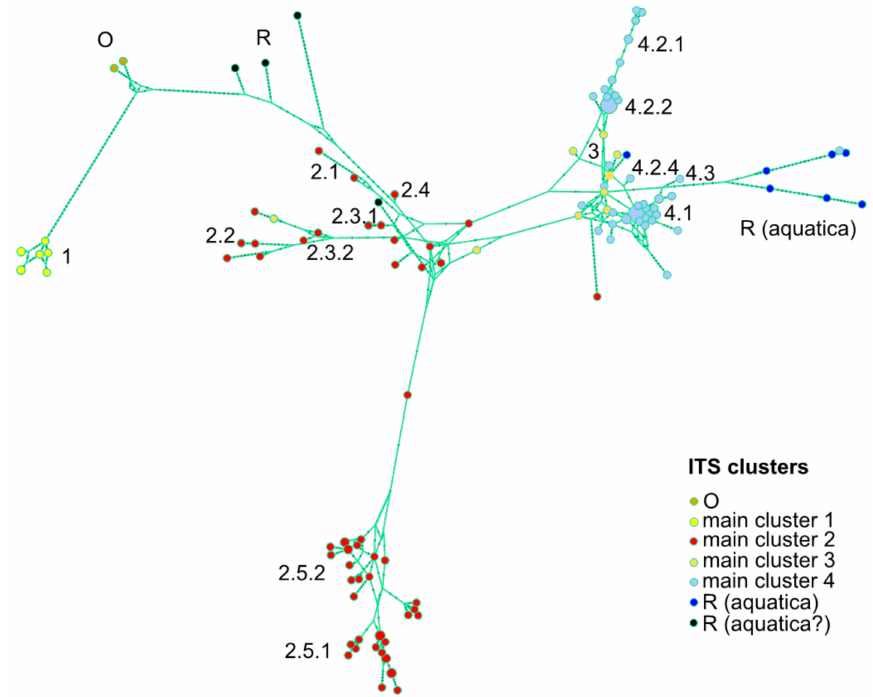
Figure 2. Haplotype network. Subcluster codes indicated next to their corresponding fields for recombinations. Colors according to ITS main clusters. Small black points indicate number of mutations compared to the closest